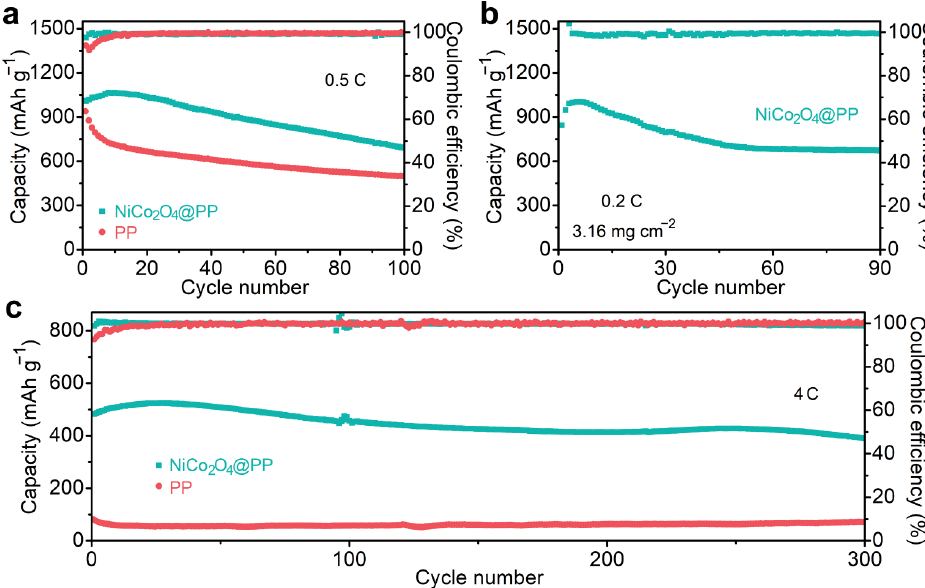
Figure 5. ( a ) Cyclic properties of the sulfur cathodes with different separators at 0.5 C. ( b ) High loading performance at 0.2 C. ( c ) High rate and long cycle comparison.